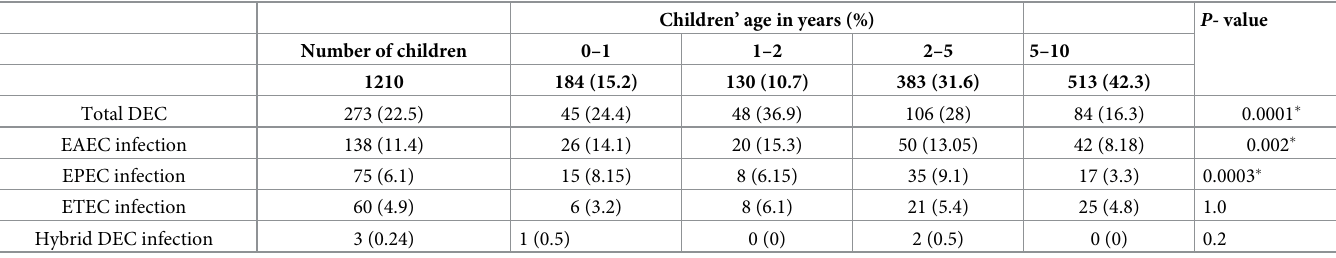
Table 3. Distribution of DEC groups by age in children with acute